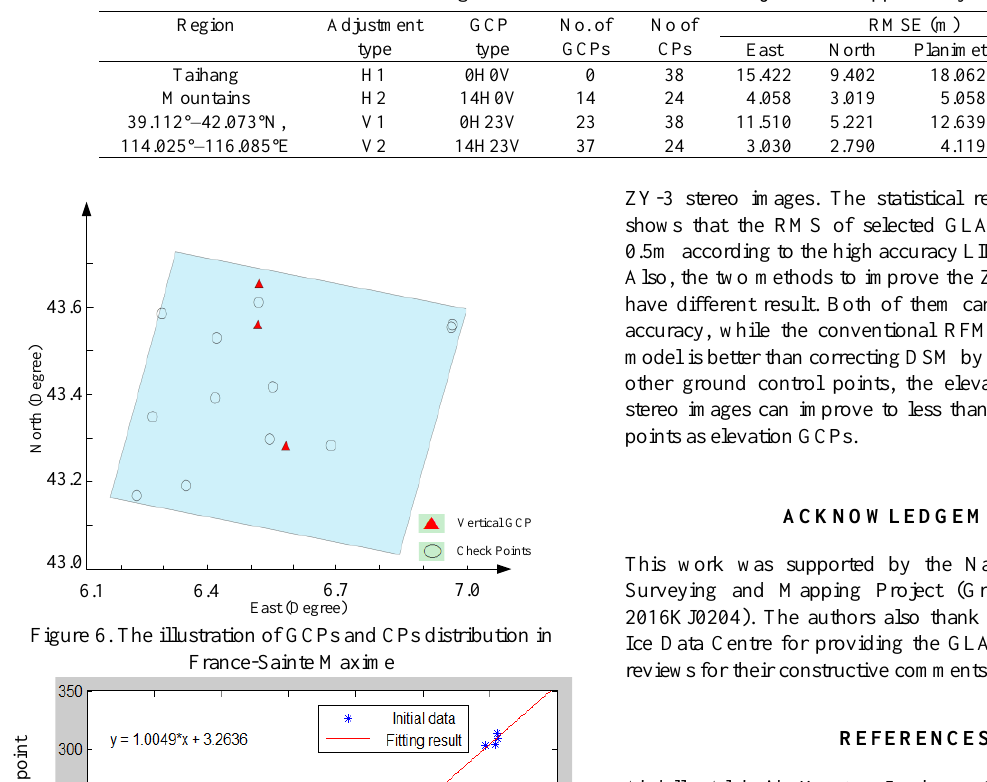
Table 2. Statistical table of Taihang Mountain ZY-3 stereo block adjustments supported by GLAS data.